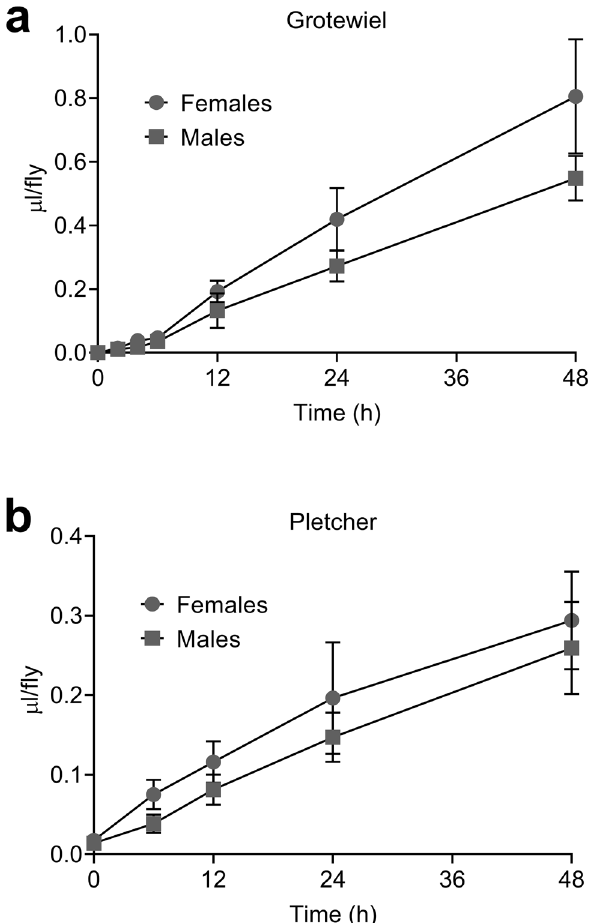
Figure 5. Con-Ex time-courses in control females and males in two different laboratories using two different media. Con-Ex with Orange 4 (1% w/v) in media increased linearly out to 48 h in males and females determined in the Grotewiel ( a ) and Pletcher ( b ) laboratories. ( a ) ExVial from GL females and males consuming 2Y10S3C medium (linear regression: females, R 2 = 0.8968; males, R 2 = 0.9431; n = 8 for each time-point). ( b ) ExVial from 10 females and males consuming 10% sugar-yeast medium (linear regression: females, R 2 = 0.8623; males, R 2 = 0.7709, n = 8 for each time-point). Slopes derived from linear regression are significantly non-zero in all cases (p < 0.0001). Females consumed more than males in both the Grotewiel ( a ) and Pletcher ( b ) studies (independent two-way ANOVAs; sex, p ≤ 0.0027; time, p <